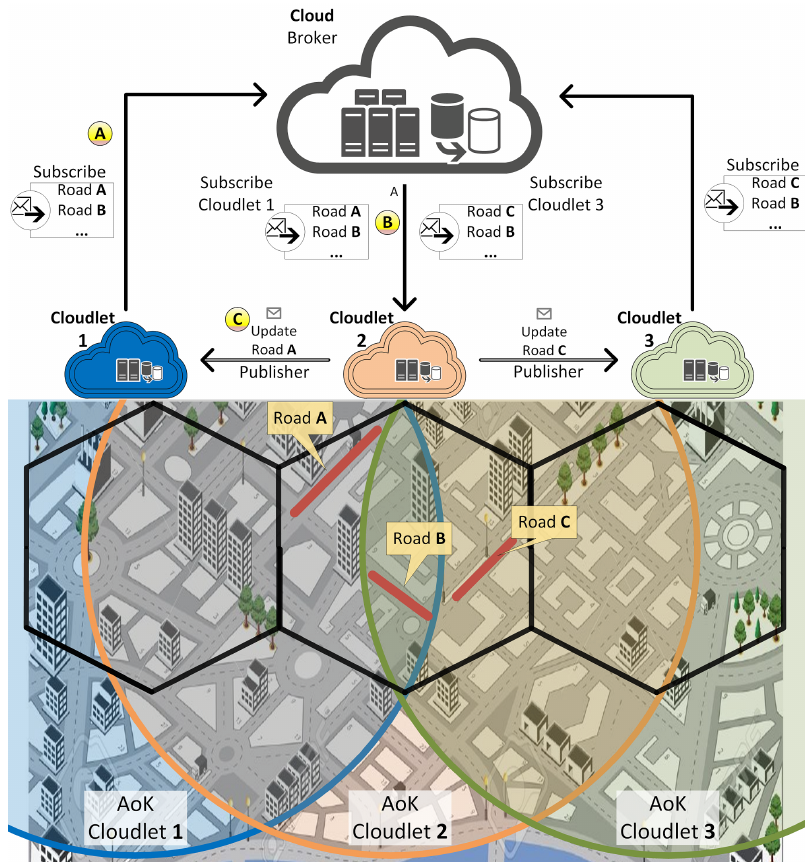
Figure 5. FOXS publish-subscribe